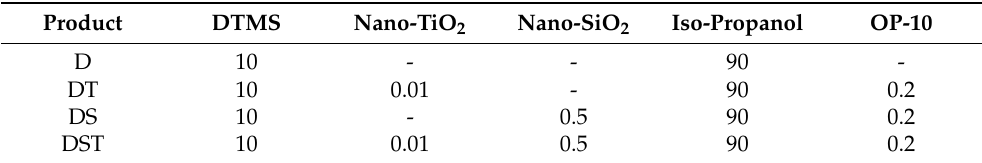
Table 1. Coating formulations in percent ( w/w ). D, dodecyltrimethoxysilane (DTMS); DT and DS, TiO 2 - and SiO 2 -modified DTMS, respectively; DST, TiO 2 and SiO 2 comodified DTMS, where iso- propanol was the solvent, OP-10 was the emulsifier, and the concentrations of TiO 2 and SiO 2 were 0.01% ( w/w ) and 0.5% ( w/w ), respectively.